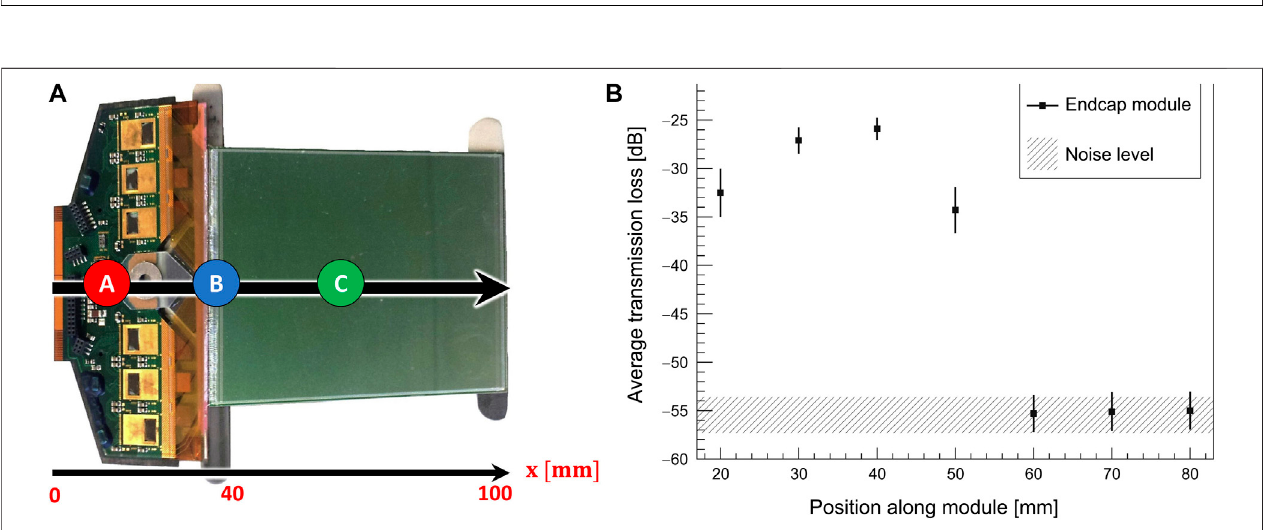
Frontiers in Physics |